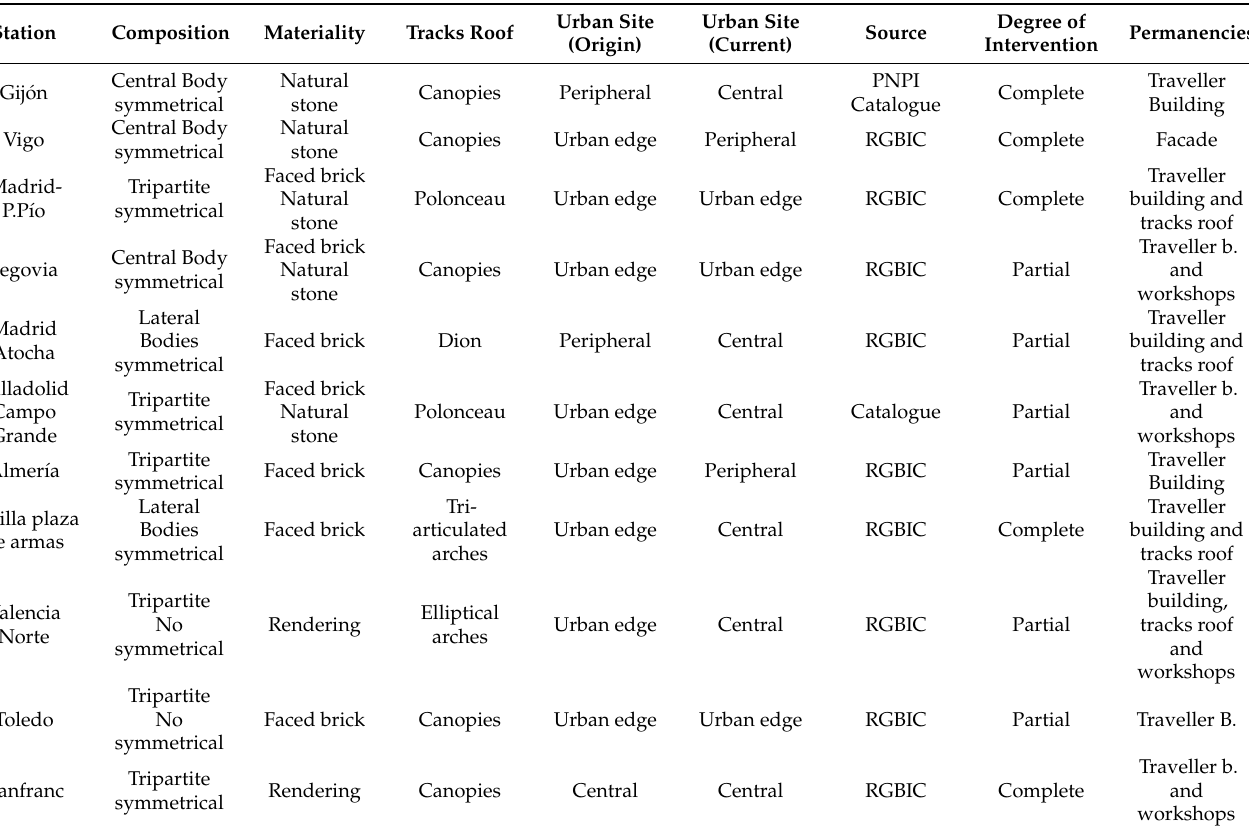
Table 4. Heritage variables. Own